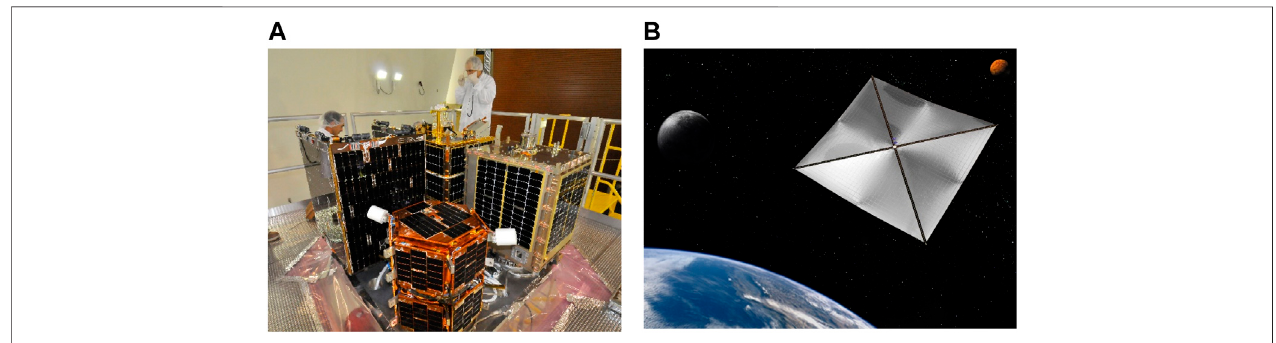
FIGURE 1 | (A) NASA ’ s FASTSAT microsatellite readied to share ride to space (NASA, 2021a). (B) NASA ejects nanosatellite from microsatellite in space. Image usedconsistentwithNASApolicy, “ NASAcontent(images,videos,andaudios)aregenerallynotcopyrightedandmaybeusedforeducationalorinformationalpurposes without needing explicit permissions ” (NASA,